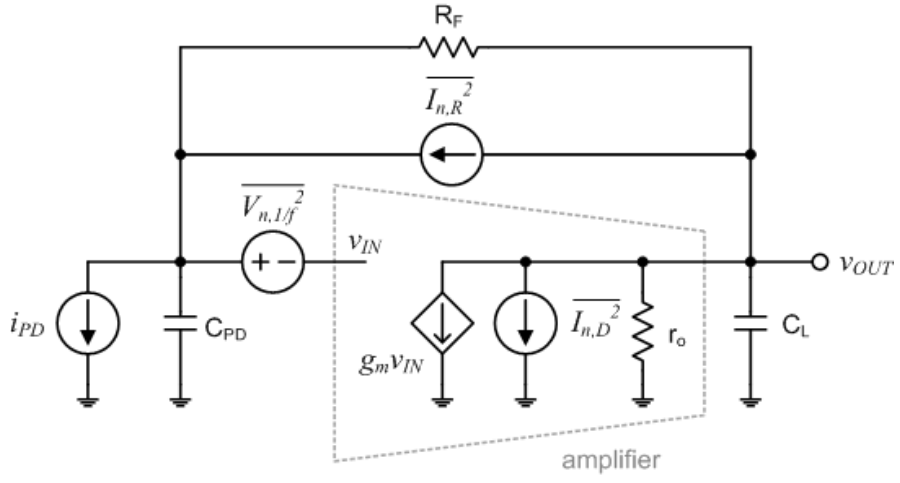
Figure 9. Simplified model of the trans-impedance amplifier for noise analysis.